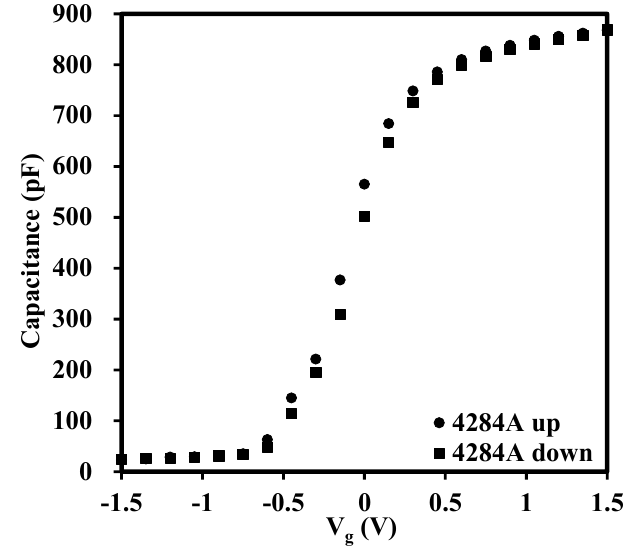
Figure 2. Conventional CV characteristics measured by Agilent 4284A for the sample with the thickness of about 22 nm. It is clear that there is an obvious hysteresis between the CV curves measured by the pulse technique while there is almost no hysteresis for the conventional